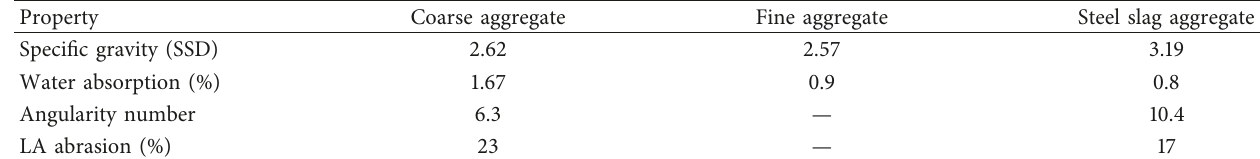
Table 2: Physical and mechanical properties of graded